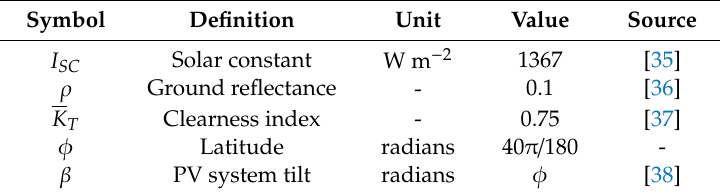
Table A1. Parameters used to estimate hourly solar irradiation on a tilted PV